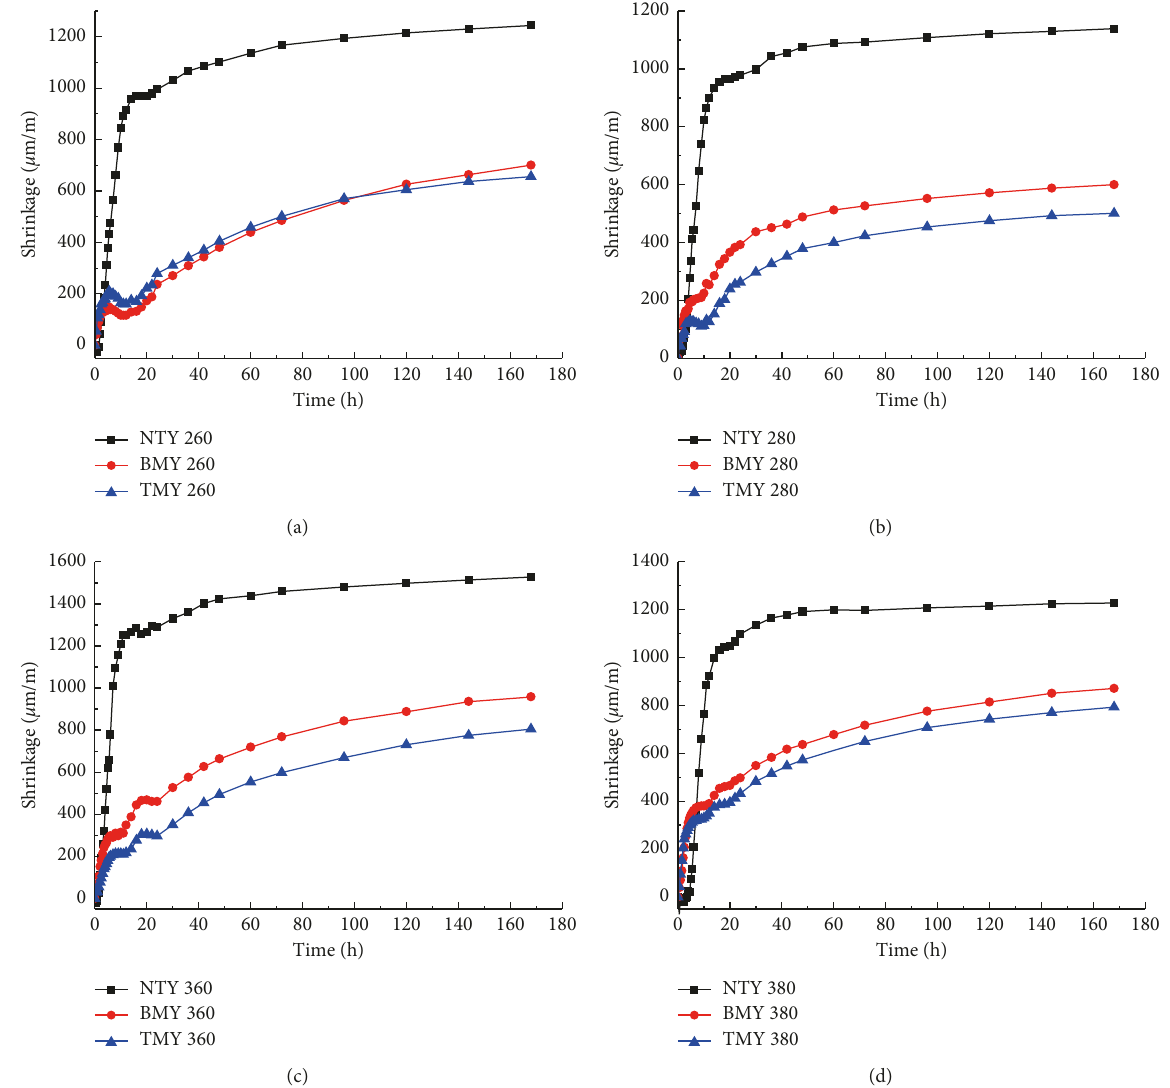
Figure 4: Early-age shrinkage of concrete under different environment conditions. (a) 20 ± 2 ° C, 60 ± 5% RH. (b) 20 ± 2 ° C, 80 ± 5% RH. (c) 30 ± 2 ° C, 60 ± 5% RH. (d) 30 ± 2 ° C, 80 ± 5% RH.